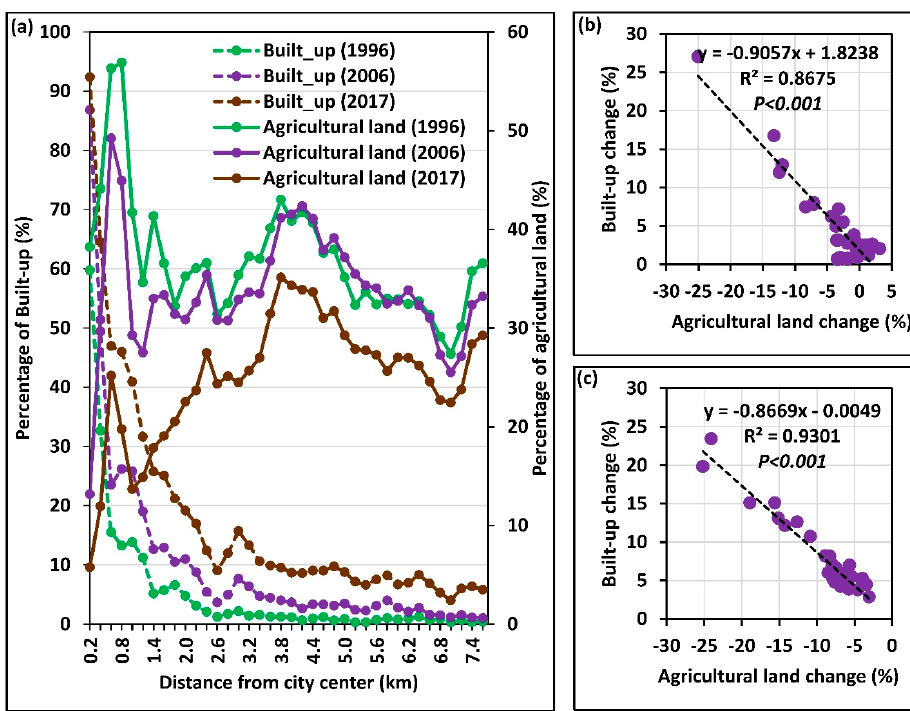
Figure 6. The spatial pattern of changes in agricultural and built-up land in the Nuwara Eliya area in 1996–2017: ( a ) Agricultural and built-up land across the gradient; ( b ) Scatter plot between agricultural and built-up changes in 1996–2006; and ( c ) Scatter plot between agricultural and built-up changes in 2006–2017.